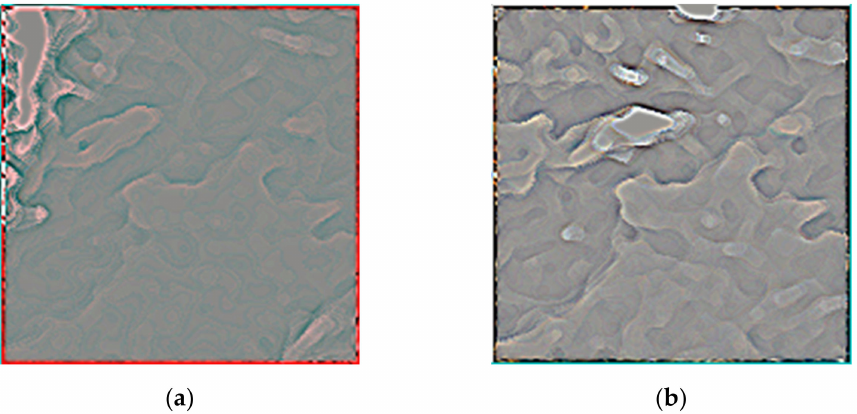
Figure 8. Convolution feature extraction diagram ( a ) Convolution diagram during severe haze; ( b ) Convolution diagram with a lower haze